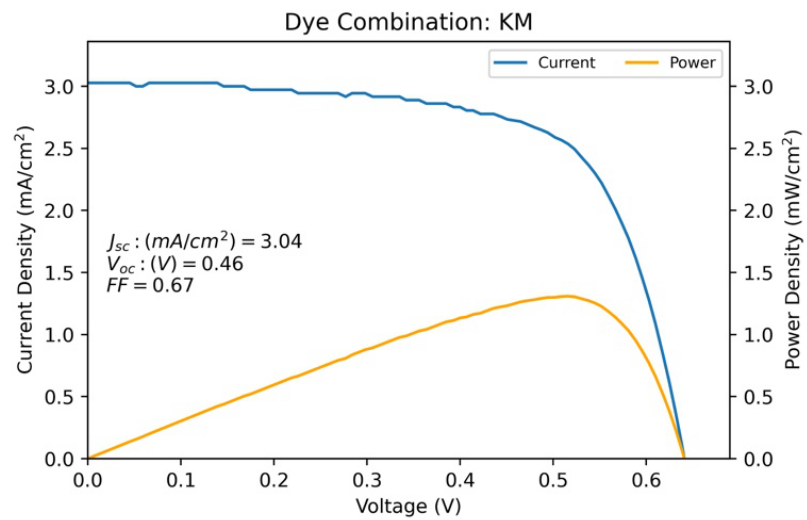
Figure 8. 1:1 molar Curcuminoids and α -Mangostin (KM) combination, with an efficiency of 1.31%.